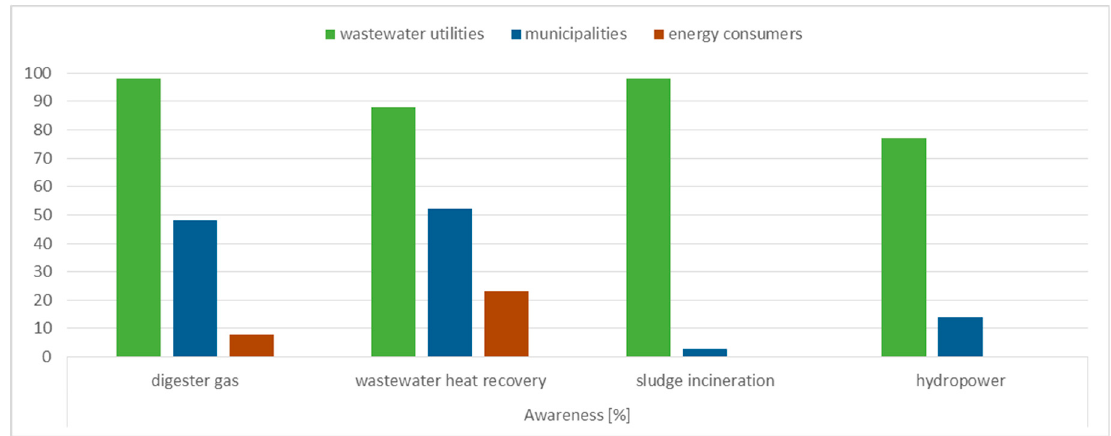
Figure 3. Awareness concerning the energetic use of wastewater.